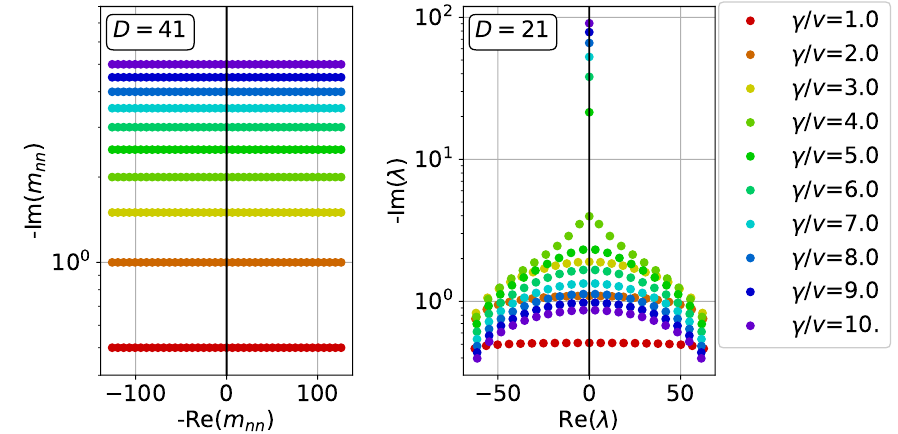
Figure 8: Representative diagonal elements (left) and spectra (right) of the ordered dissipative scattering model, see